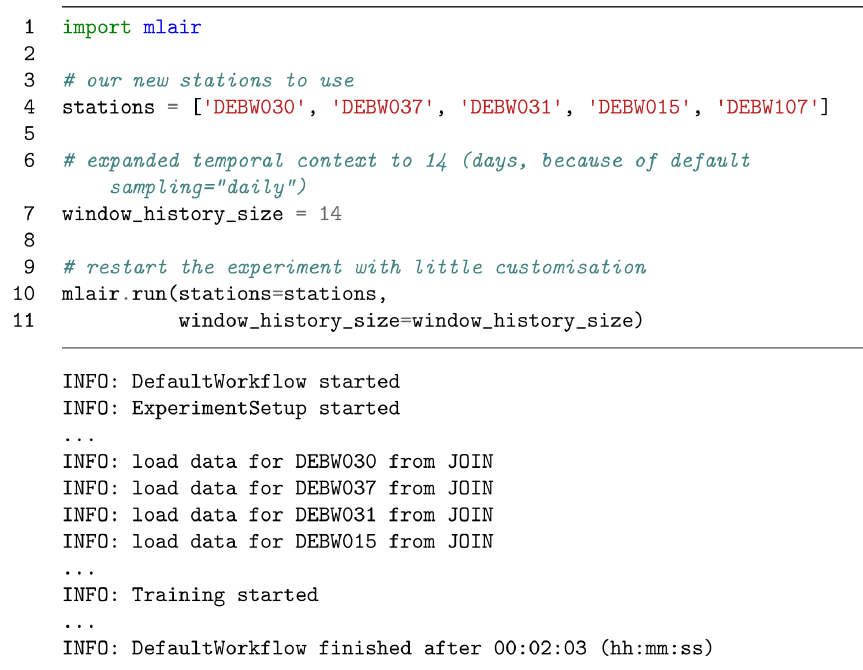
Figure 3. The MLAir experiment has now minor adjustments for the parameters stations and window_history_size